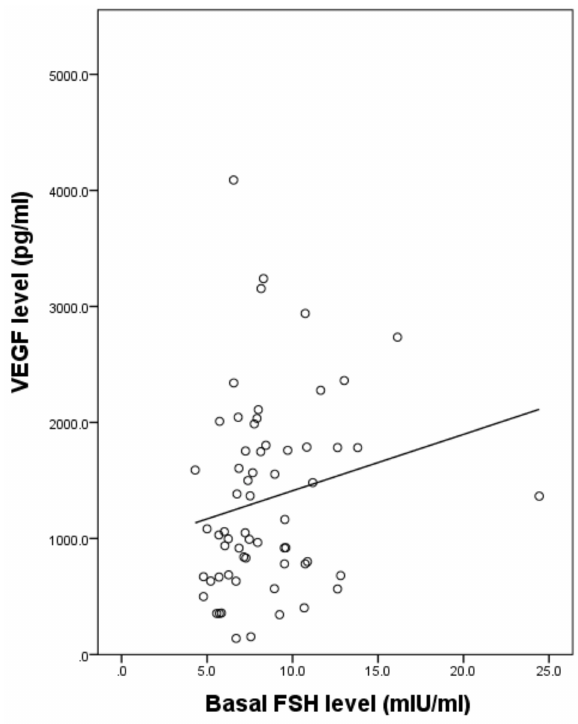
Figure 2. Correlation between intrafollicular VEGF level and basal FSH level. The correlation between intrafollicular VEGF and serum basal FSH level was weakly positive (Spearman coefficient = 0.274, p < 0.05).